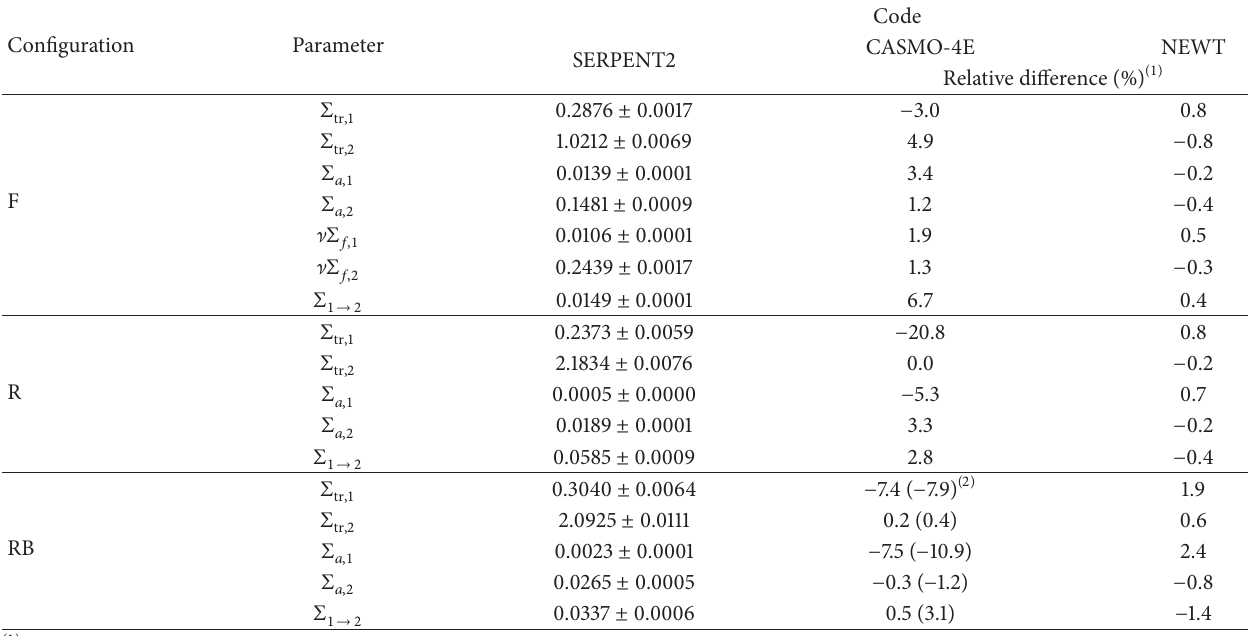
Table 4: The two-group constants generated by unit models.